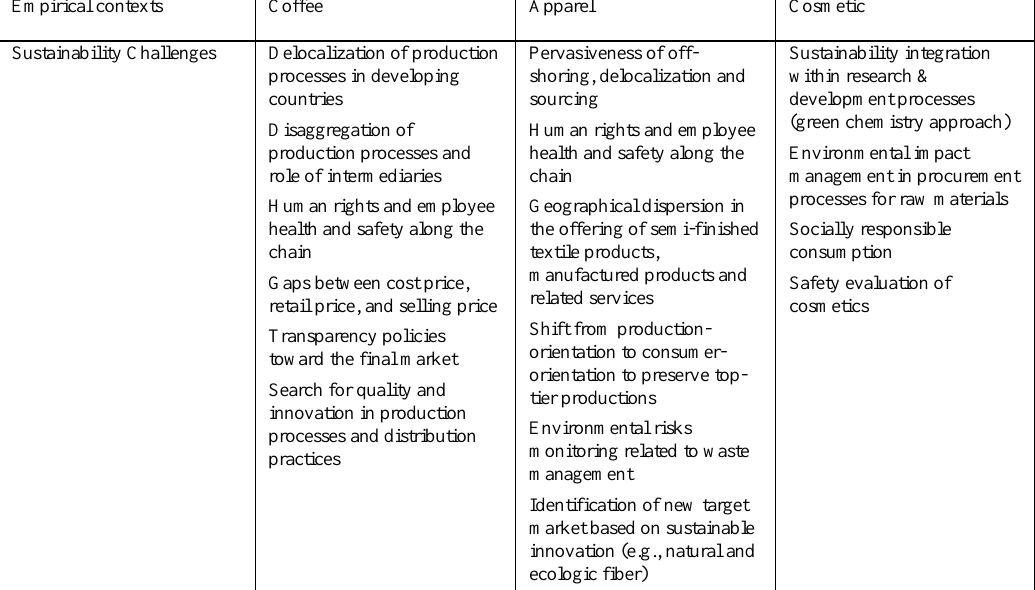
Table 1 : Current Dynamics in Coffee, Apparel and Cosmetic Supply Chains Empirical contexts Coffee